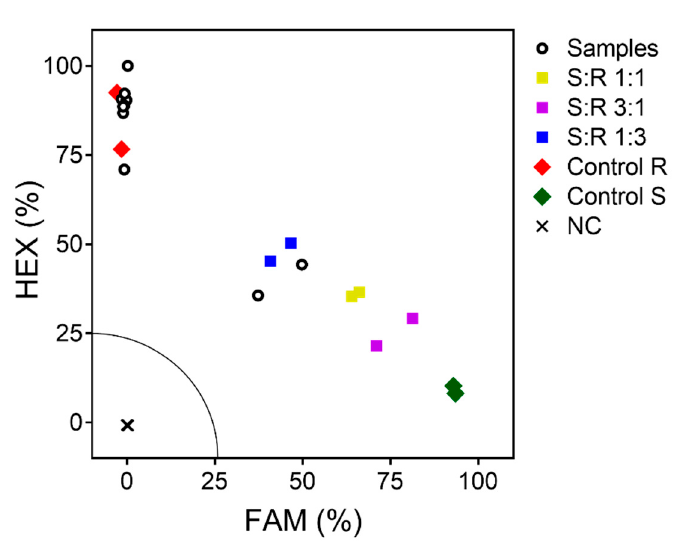
Figure 6. Kompetitive Allele Specific (KASP) assay to genotype the Trp574Leu target site mutation in tetraploid wild poinsettia ( Euphorbia heterophylla ). The FAM fluorophore represents tryptophan (TGG) while HEX is associated to leucine (TTG) at position 574. Green and red diamonds represent different proportions of R and S genotypes, respectively. Open circles are cDNA samples of R1 and R2 populations analyzed in this study. Most plants were homozygous for Trp574Leu, except two R2 plants that were heterozygous at the 3:1 (R:S) proportion.